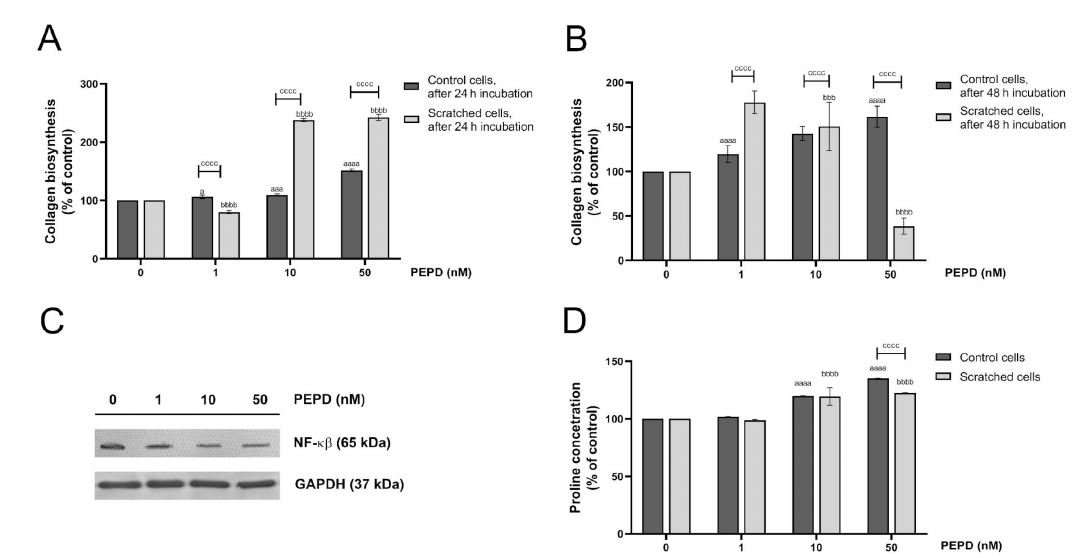
Figure 9. Extracellular prolidase stimulates collagen biosynthesis in HaCaT cells via an increase in proline synthesis and a downregulation of the level of NF-k β . ( A , B ) Collagen biosynthesis was measured in prolidase-treated HaCaT cells (1–50 nM) after 24 and 48 h. ( C ) Analysis of NF-k β in the cell lysate of keratinocytes upon PEPD supplementation after 24 h using Western immunoblotting. Representative blot images are shown (densitometric analysis of presented protein is included in Supplementary Materials (Supplementary Figure S10). ( D ) LC–MS-based analysis of proline concentration in prolidase-treated HaCaT cells after 24 h incubation. The results represent a mean ± SEM of three replicates are significant at a = < 0.05, aaa , or bbb , < 0.001, and aaaa , bbbb, or cccc < 0.0001 and are marked as a vs. control (0 nM of PEPD) of unscratched (control) cells, b vs. control (0 nM of PEPD) of scratched cells, and c marked unscratched (control) cells vs. scratched cells in the same concentration of PEPD,